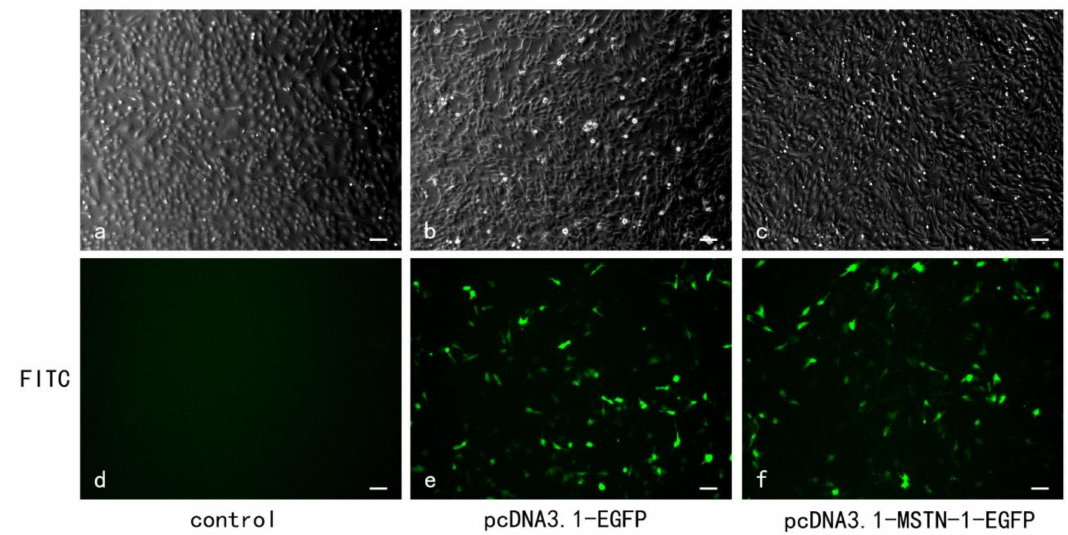
Figure 5. The Images of muscle cells after transfection at 24 h; bar = 100 µ m. Transfection e ffi ciency of muscle cells isolated from skeletal muscle of Japanese flounder and cultured with Dulbecco’s Modified Eagle Medium (DMEM) supplemented with 10% fetal bovine serum (FBS) at 23 ◦ C for 24 h. Cells were treated with PBS ( a , d ) and transfected with pcDNA3.1-EGFP plasmid ( b , e ) and pcDNA3.1-MSTN-1-EGFP plasmid ( c , f ). Fluorescence image showed a certain number of EGFP-expressed cells of pcDNA3.1-EGFP group (28.99% ± 2.04%) ( e ) and pcDNA3.1-MSTN-1-EGFP group (28.62% ± 1.50%) in the fluorescein isothiocyanate (FITC) channel ( f ).